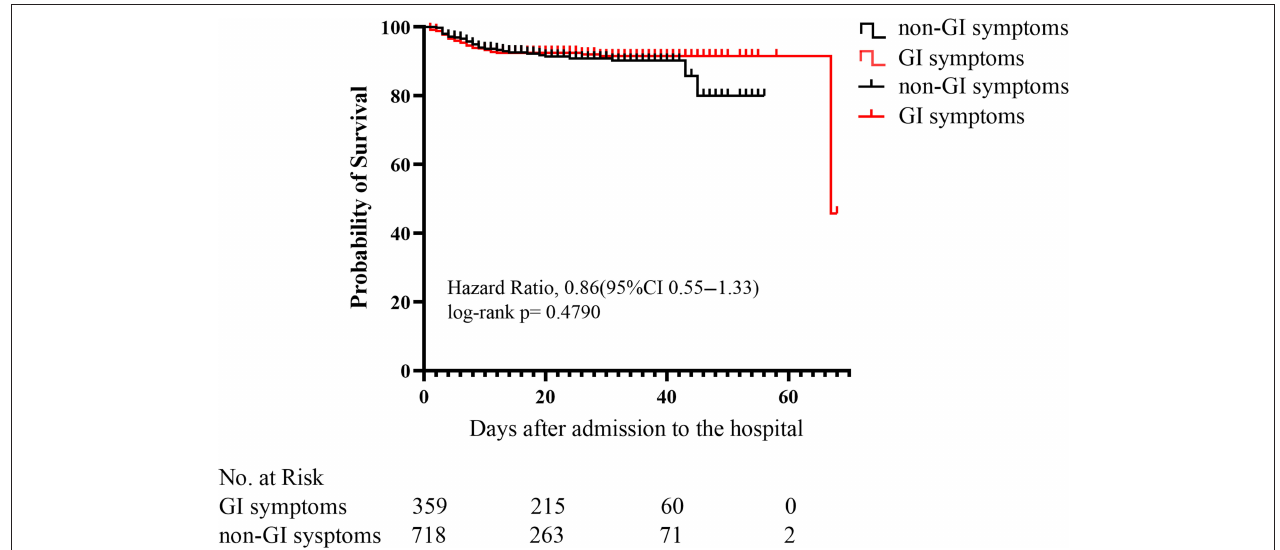
FIGURE 2 | Kaplan-Meier (KM) survival curve for COVID-19 patients with or without GI (gastrointestinal) symptoms. p -values were for differences by log-rank-test.